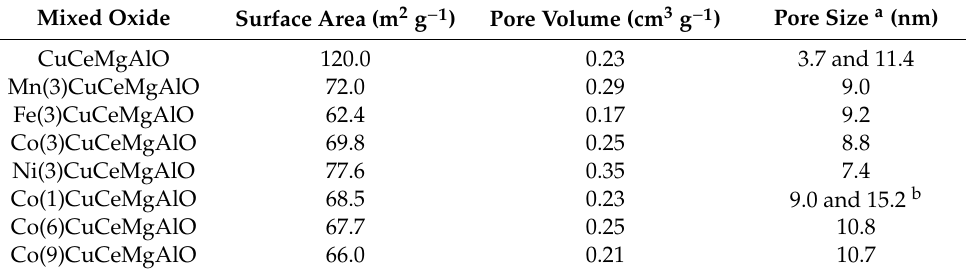
Figure 8. Electronic spectra of the transition metal-promoted CuCeMgAlO mixed oxide catalysts. The adsorption-desorption isotherms of the unpromoted and transition metal-promoted CuCeMgAlO mixed oxides are shown in Figure S8. All the solids revealed type IV isotherms with either H3-type or a combination of H3 with H2b types hysteresis loops specific for mesoporous materials with either slit-shaped pores or more complex pore structures [47]. The specific surface areas (Table 5) of all the transition metal-promoted CuCeMgAlO samples were close together and, for the Co(x)CuCeMgAlO mixed oxides, varied irrespective of the Co content, in line with their similar particle sizes of the periclase-like phase ( D = 13.8 ± 1.5 nm). However, their specific surface area was lower than that of the unpromoted CuCeMgAlO mixed oxide, in line with its lower particle size of the periclase-like phase ( D = 10.1 nm). Table 5. Textural properties of the LDH-derived mixed